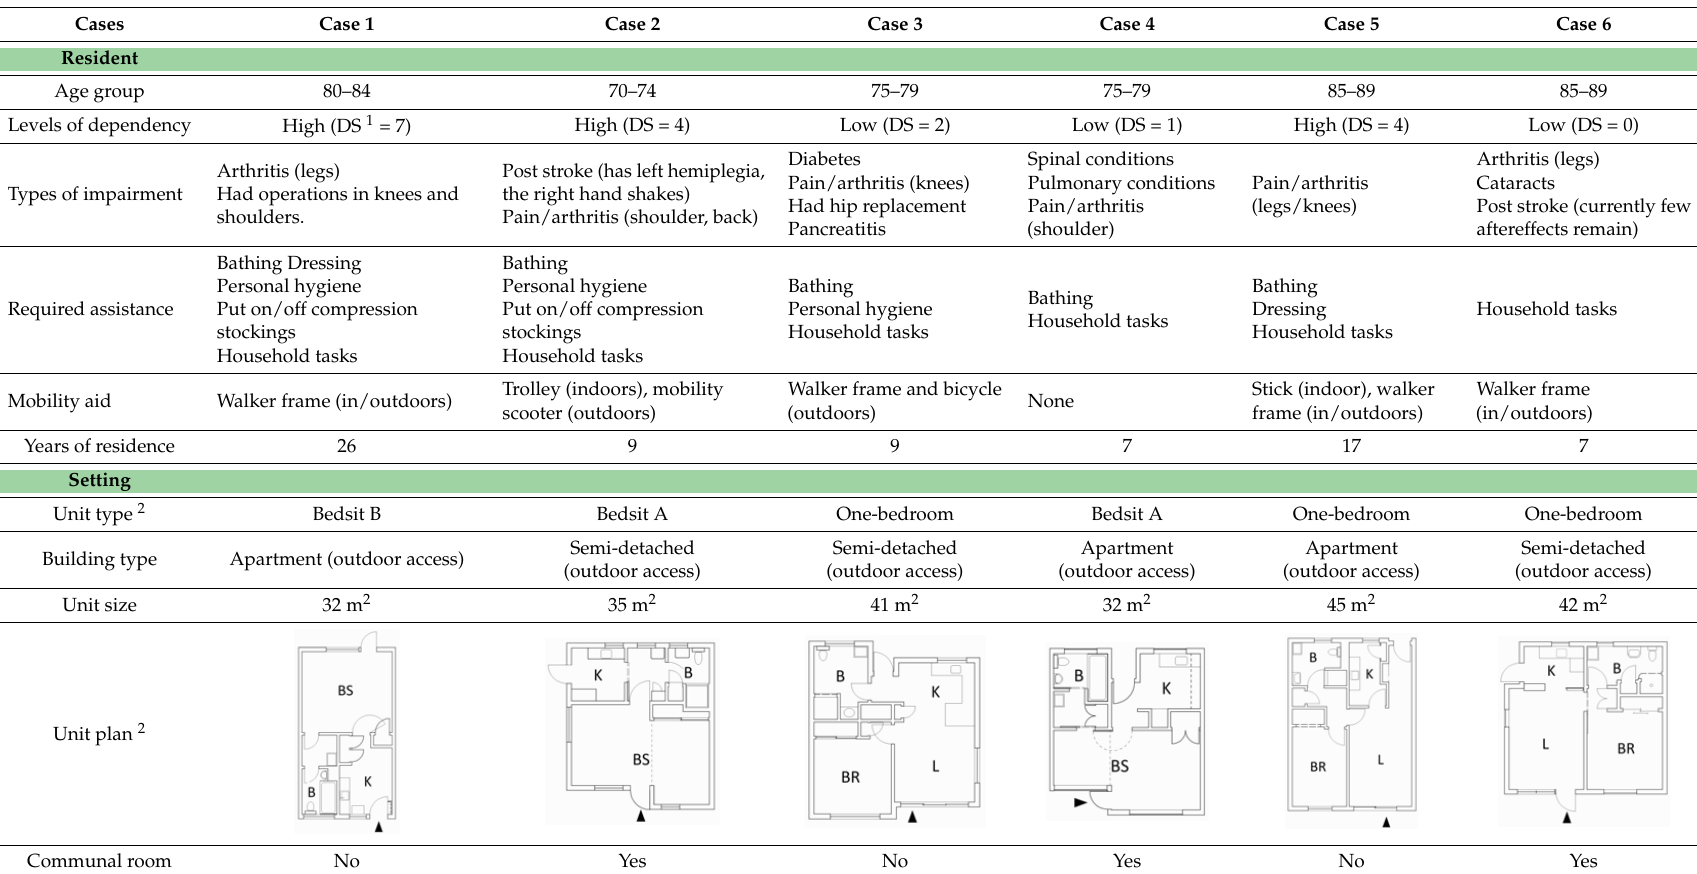
Table 1. Basic information on residents and settings.